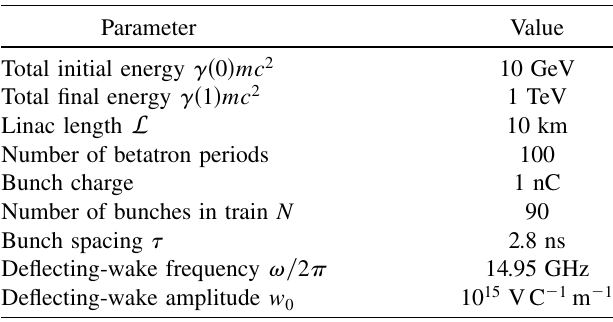
TABLE I. Nominal top-level linear-collider design